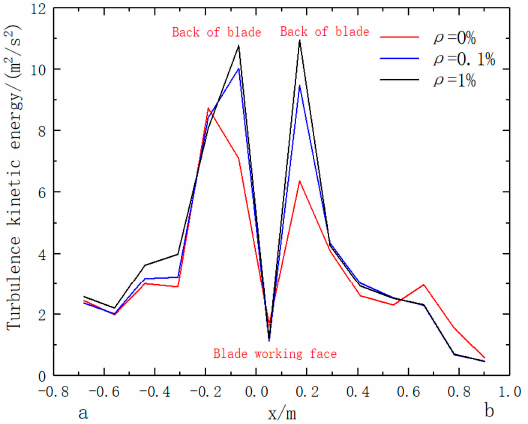
Figure 8. Cross-section ab shows the variation trend of turbulence kinetic energy with different sediment concentrations.